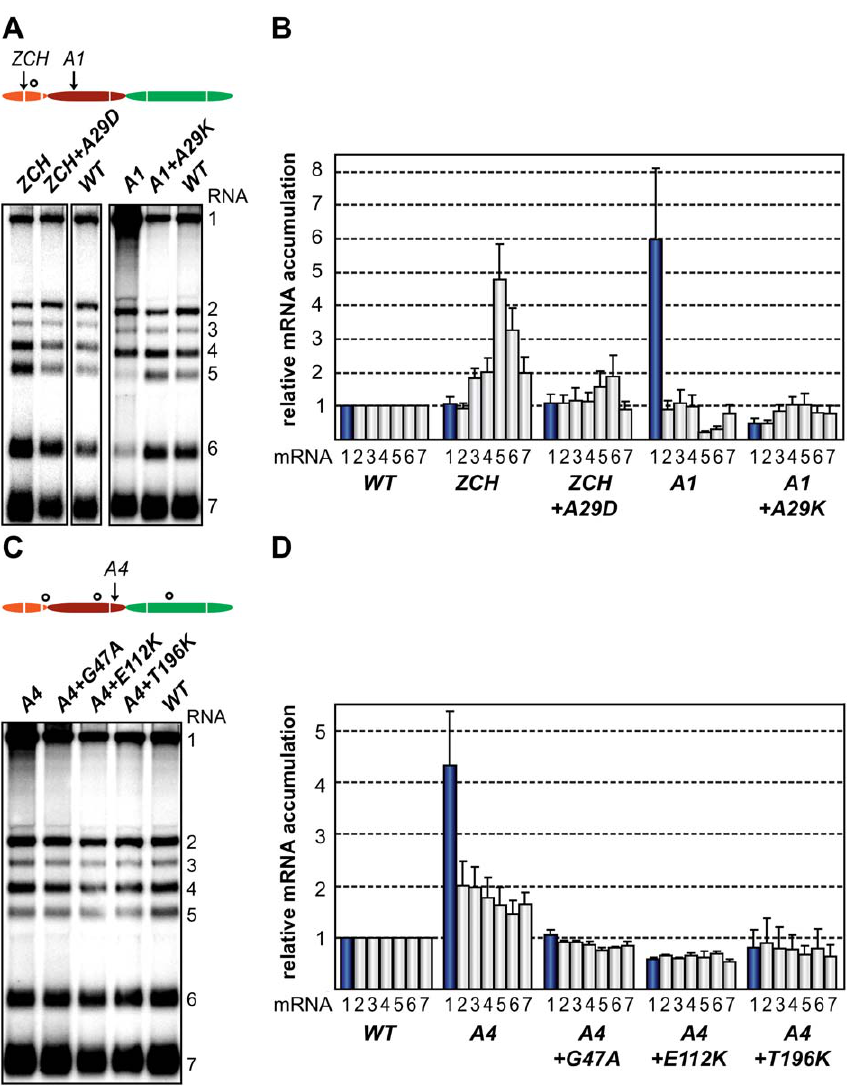
Figure 7. Second-site mutations in nsp1 moderate species-specific defects in mRNA accumulation. (A–D) Gel hybridization analysis and quantification of EAV-specific mRNA accumulation. (A) BHK-21 cells were transfected with ZCH and A1 mutants, reconstructed pseudorevertants, and wt controls. The positions of the originally mutated amino acid clusters are indicated with arrows; the open circle denotes the position of second-site mutations. Viral mRNAs were analyzed 11 h post-transfection by gel hybridization as described above. (B) For ZCH + A29D and A1 + A29K, the accumulation levels of each viral mRNA were quantified by phosphorimaging and the values were normalized to the wt level of accumulation of each corresponding viral mRNA from the same experiment, set at 1. Genomic RNA levels are shown as blue bars. The relative values correspond to the means from three independent transfections and error bars denote the standard deviation. The relative accumulation levels of viral mRNAs at 11 h post-transfection for the ZCH and A1 mutants are derived from Fig. 4B and are represented here to facilitate comparison between mutant and pseudorevertant phenotypes. (C) BHK-21 cells were transfected with the A4 mutant, reconstructed pseudorevertants and a wt control. The positions of the originally mutated amino acid cluster and the second-site mutations are indicated as in (A). Viral mRNAs were analyzed 11 h post-transfection. (D) For A4 + G47A, A4 + E112K, and A4 + T196K, quantification of relative viral mRNA accumulation levels was performed as described in (B). Similarly, the relative accumulation levels of viral mRNAs at 11 h post-transfection for the A4 mutant derived from Fig. 4B are represented to facilitate